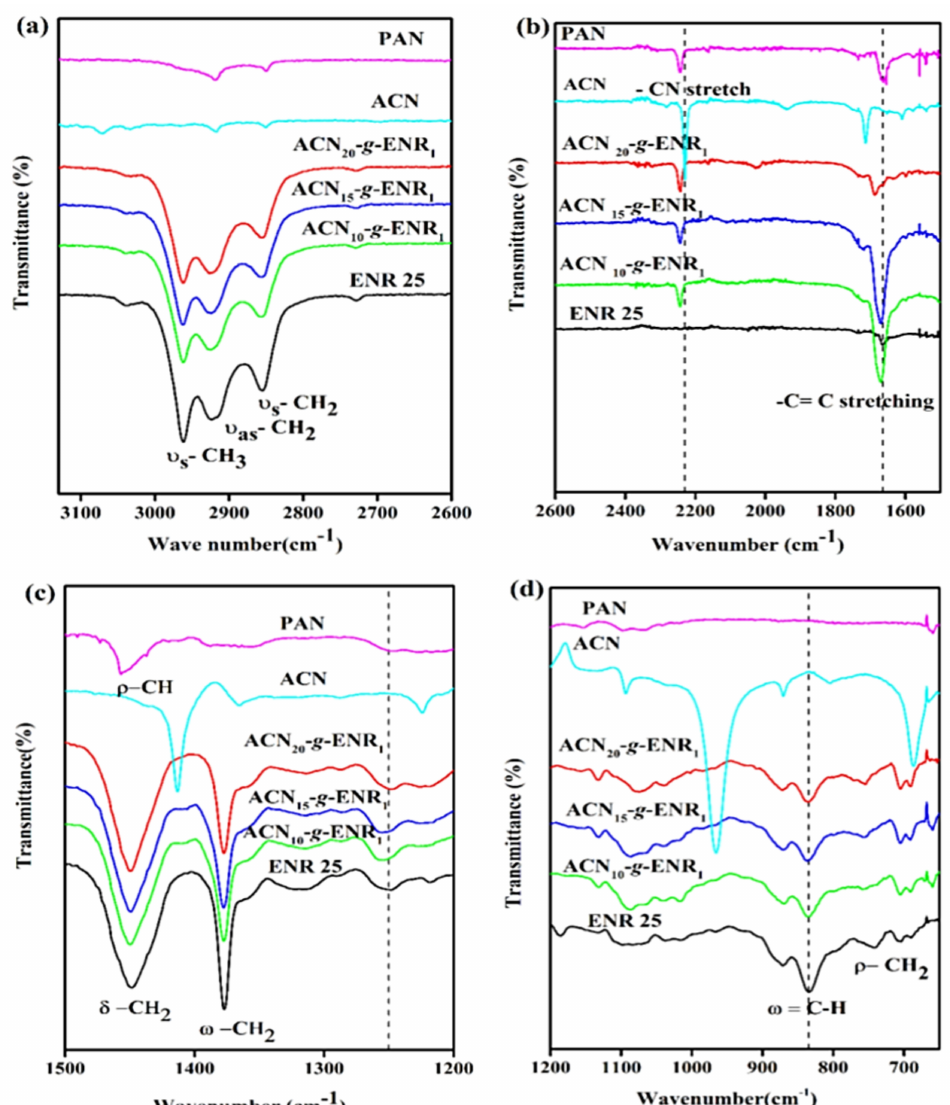
Figure 3. FTIR of ENR- 25, ACN, polyacrylonitrile (PAN), and ACN- g -ENR products at different mole ratios. ( a ) –CH stretching ( b ) -C ≡ N vibrations and -C=C- stretching ( c ) –CH 2 in -plane,